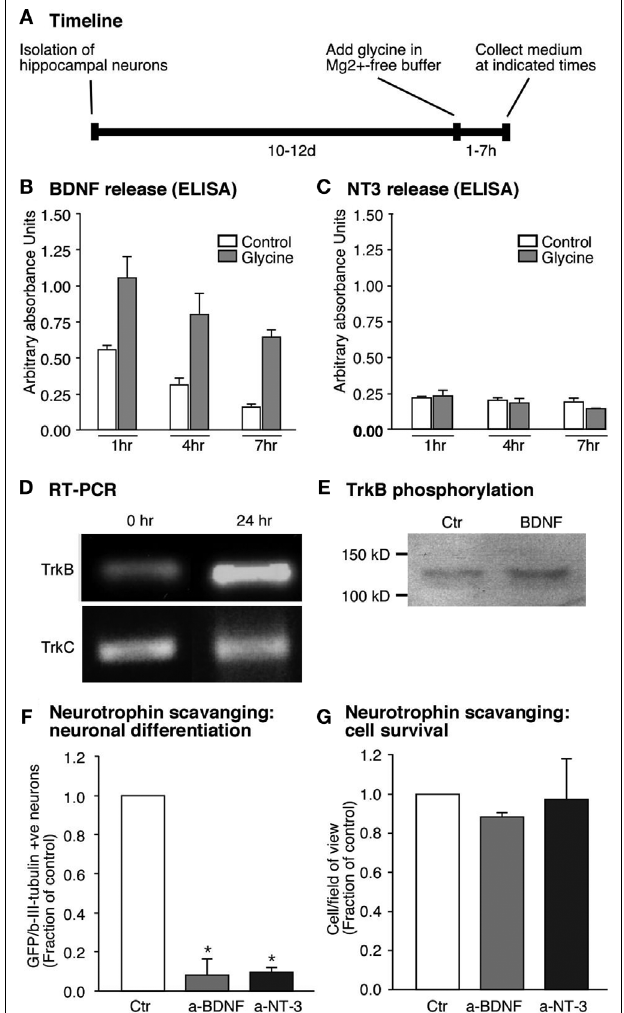
FIGURE 4 | Glycine induced neuronal differentiation is mediated by the neurotrophin BDNF. (A) Time line for the experiments where glycine induced synaptic plasticity was induced and media collected from hippocampal neuronal cultures at set time points. (B,C) Glycine induced potentiation causes increased release of BDNF from the hippocampal neurons. But NT3 a closely related neurotrophin is not regulated by glycine (C) . (D) RT-PCR analysis confi rms expression of trkB- and trkC-receptors in neural precursor cells. The trkB receptor is upregulated early upon differentiation whereas the trkC receptor remains unchanged. (E) Precursor cells were cultured under differentiation conditions for 24 h, followed by stimulation with BDNF (50 ng/ ml) for 15 min. Immunoblots of equal amounts of cell lysates were probed with anti phospho-TrkB antibody. (F,G) Neutralizing the neurotrophins released by the neurons results in a strong decrease in neuronal differentiation from the precursor cells. Each experiment was performed three